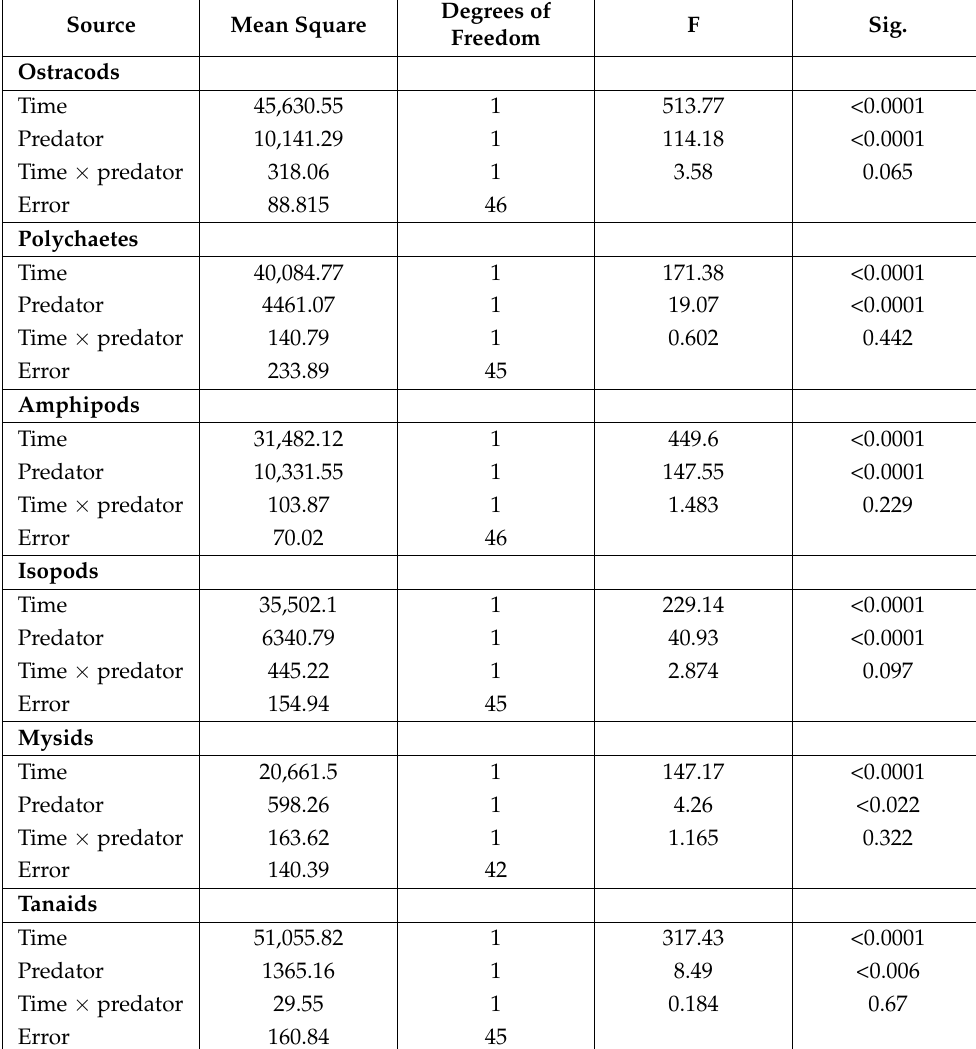
Table 1. Results of the analyses of variance conducted on the proportion of benthic invertebrates emerging from sediments in the presence/absence of a predator and time of day in the microcosm experiments. Results are considered significant when p <